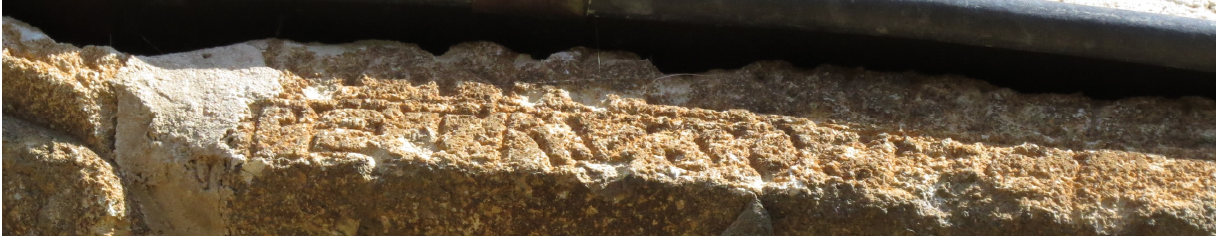
Figure 20. AN…S..N..EL… PETRUS O…E, detail archivolt, west façade, Saint-Martin Church , 12th